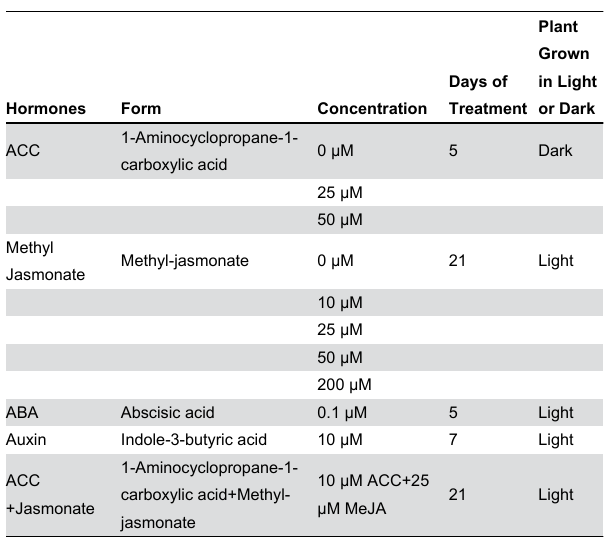
Table 2. Hormones and treatment conditions used to evaluate phenotypes of JnRAP2-like over-expressing transformed